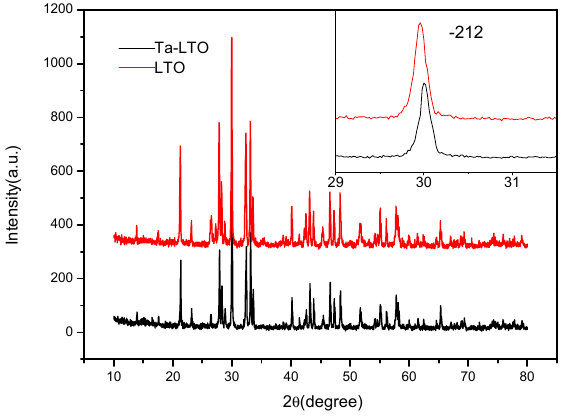
Figure 5. XRD patterns of the Ta-LTO and La 2 Ti 2 O 7 crystalline powder. The inset shows the magnified patterns of main peak.